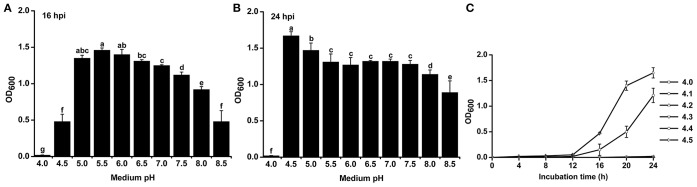
Growth rate of R. solanacearum under different pH conditions. R. solanacearum was grown in B medium with different pH, and the bacterial concentration of each treatment was determined by measuring the OD600 value at 16 h post-incubation (hpi) (A) and at 24 hpi (B). (C) Growth curve of R. solanacearum from pH 4.1 to 4.5. Each point represents the average bacterial concentration of three replicates, and error bars indicate the standard deviation. Small letters indicate a significant difference among different pH conditions (ANOVA, Duncan's multiple test).